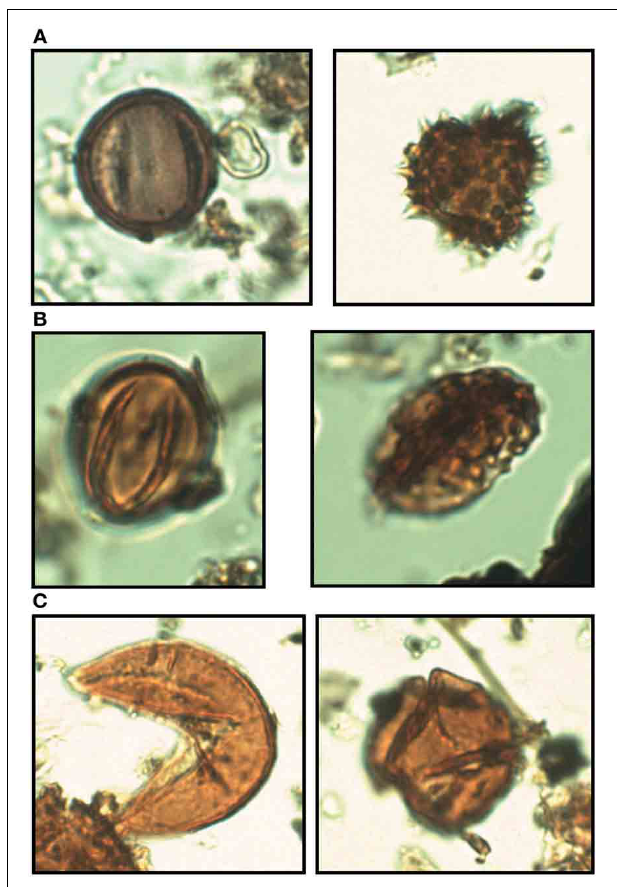
FIGURE 7 | Pollen preservation. (A) Well preserved Platanus (left) and Asteraceae (right) pollen grains from the Zaca Lake core. (B) Pollen grains from the Zaca Lake core [Indeterminate (left), and Asteraceae (right)] which show evidence of severe degradation associated with chemical weathering such as oxidation. Spines in Asteraceae grains allow for positive identification despite severe degradation (C) Pollen grains (both Quercus ) from soil which show evidence of crumpling and breaking associated with mechanical